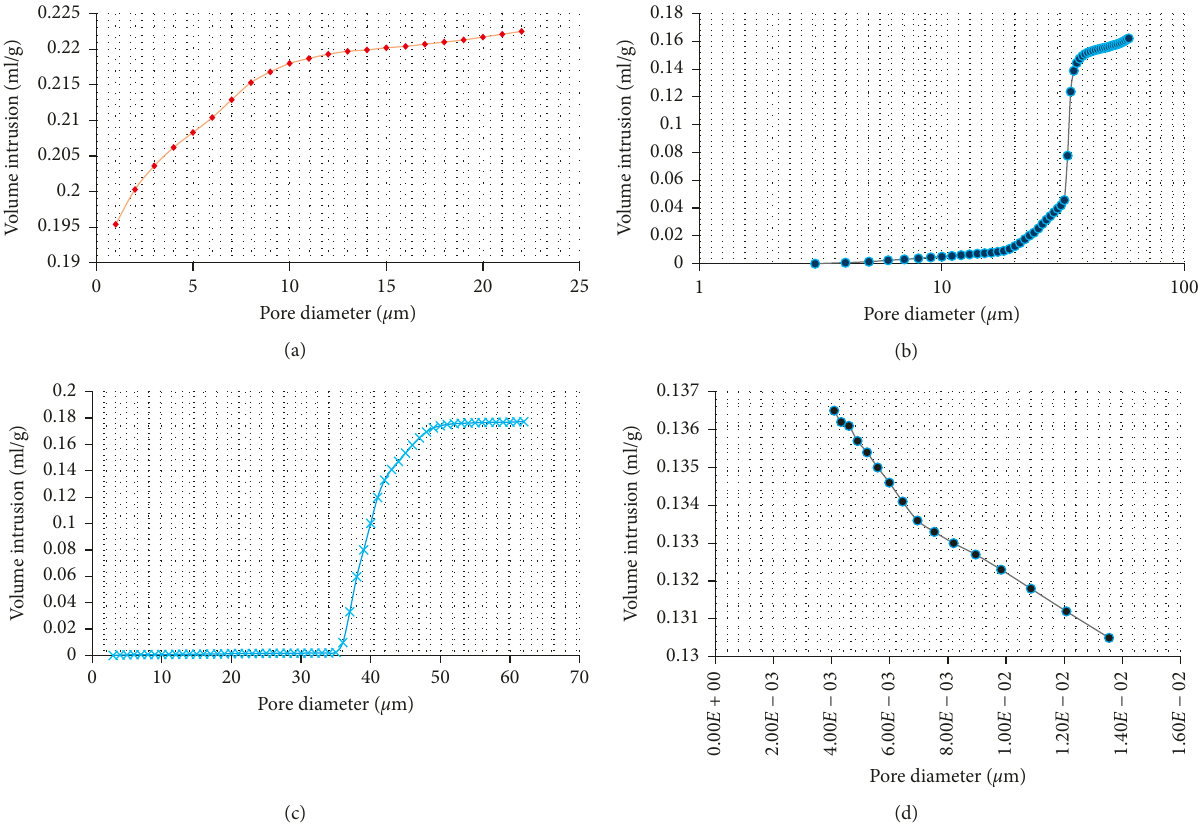
Figure 12: Intruded volume of MIP of geopolymers. (a) Sample SMF1, (b) sample SMS1, (c) sample SMSB1, and (d) sample